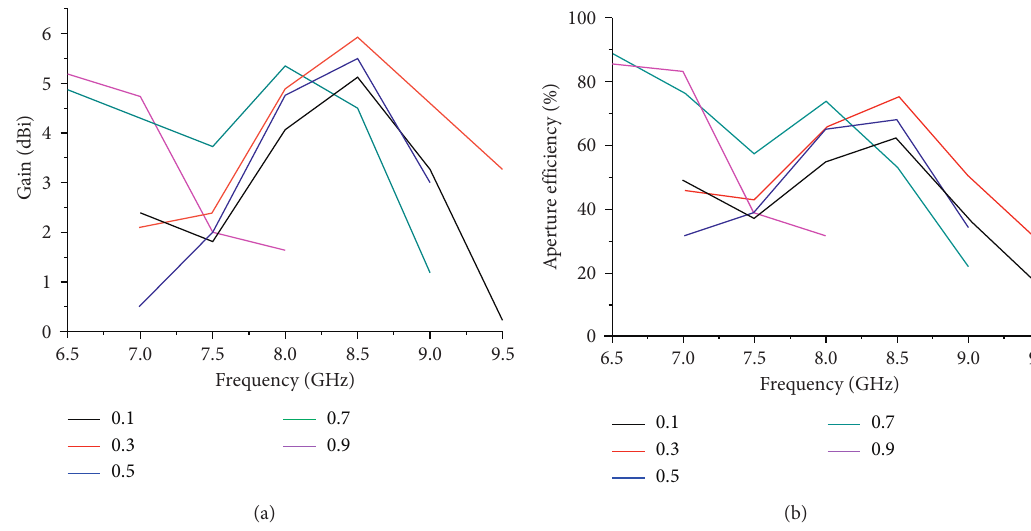
Figure 8: The measured results of (a) antenna gain and (b) aperture efficiency.